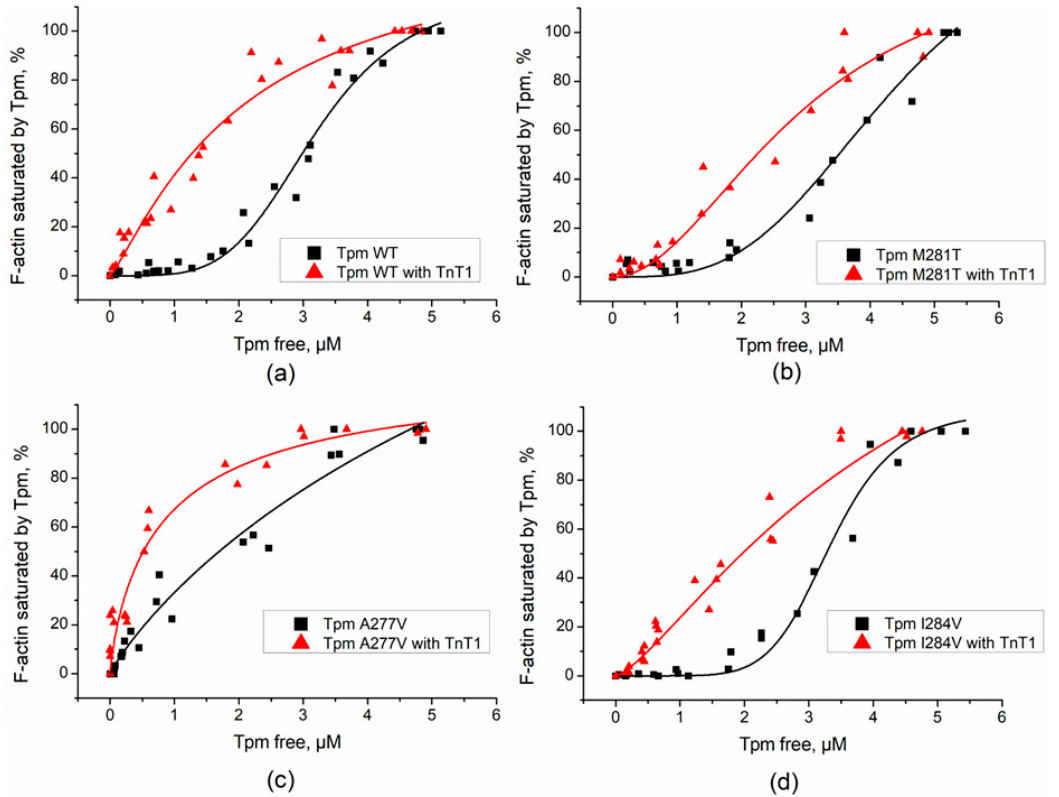
Figure 2. The affinity of the Tpm WT and the C-terminal mutants to F-actin in the presence of TnT1. Results obtained by the co-sedimentation assay are plotted as a fraction of F-actin saturated by Tpm against the concentration of free Tpm found in the supernatant. The estimated K 50% were ( a ) 3 ± 0.2 µM for WT alone and 1.25 ± 0.11 µM for Tpm WT with TnT1, ( b ) 3.5 ± 0.22 µM for M281T alone and